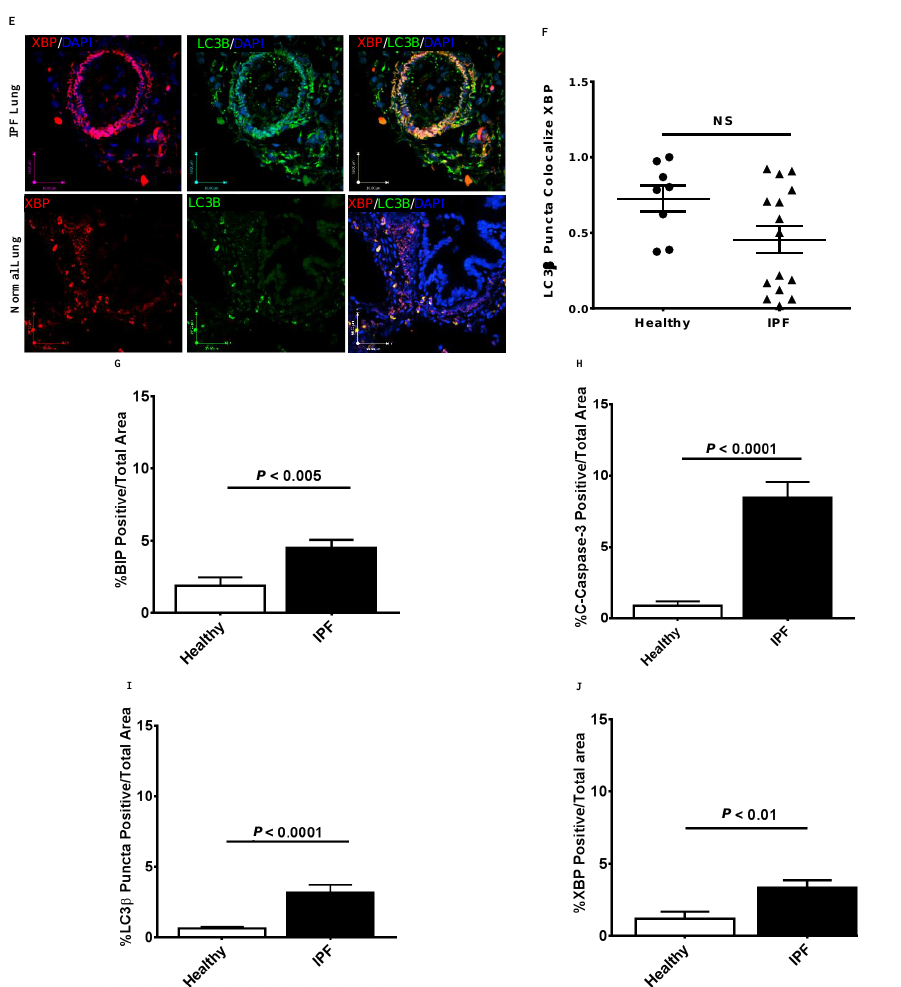
Figure 1. Co-localization of cell stress markers in IPF lung tissues. ( A ) Representative histological images of immunofluorescence confocal microscopy of IPF and non-IPF lung tissues for cleaved caspase-3 (green), BiP (red), and DAPI (blue). Co-localization can be seen as a light orange color in dotted areas in the merged images (far right side). ( B ) IPF lungs had significantly greater co-localization of c-caspase-3 and BiP compared to non-IPF lungs ( p < 0.001). ( C ) Representative histological images of immunofluorescence confocal microscopy of non-IPF and IPF lung tissues for LC3 β puncta (green), BiP (red), and DAPI (blue). Very little co-localization is observed in the merged images (far right side) for both non-IPF and IPF lung tissues. ( D ) There was no statistically significant difference in co-localized BiP and LC3 β puncta between IPF and non-IPF lungs ( p = NS). ( E ) Representative histological images of immunofluorescence confocal microscopy of non-IPF and IPF lung tissues for LC3 β puncta (green), XBP1 (red), and DAPI (blue). Some co-localization is observed in the merged images (far right side) for both non-IPF and IPF lung tissues. ( F ) There was no statistically significant difference in co-localized XBP1 and LC3 β puncta between IPF and non-IPF lungs ( p = NS). The percentage of positive signals for BiP ( G ), XBP1 ( H ), LC3 β puncta ( I ), and cleaved caspase-3 ( J ) was measured as the ratio of areas between the region of interest and the total image area. This was performed on all the images captured from sections for each lung tissue for all subjects. Data were collected in triplicate, and results are represented as the overall average for all the captured images. Note: Magnification was × 40 for images in Panels A , C , and E (scale bars are included in each image). For statistical calculations in Panels A – F , areas with co-localization of any two cell stress markers were calculated using ImageJ in both non-IPF and IPF lungs. The middle horizontal line in Panels B , D , F represents the median value in each group. Results in Panels G – J are represented as means ± SD. A p -value of <0.05 was considered statistically significant. GraphPad Prism 9 was used for all analyses. Abbreviations: NS (not